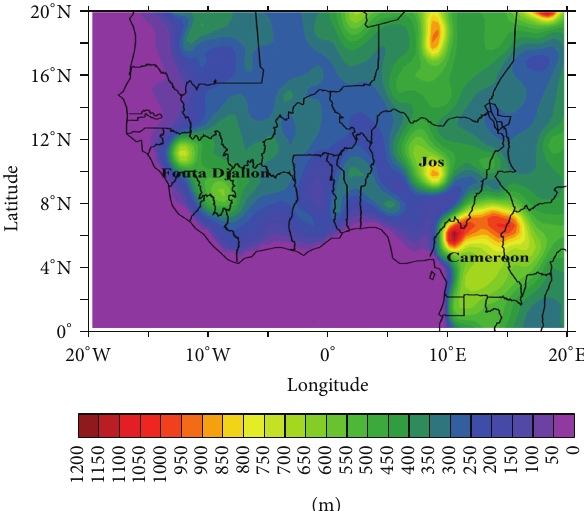
Figure 2: The topography as seen by the model in the study domain with resolution of 50 km.